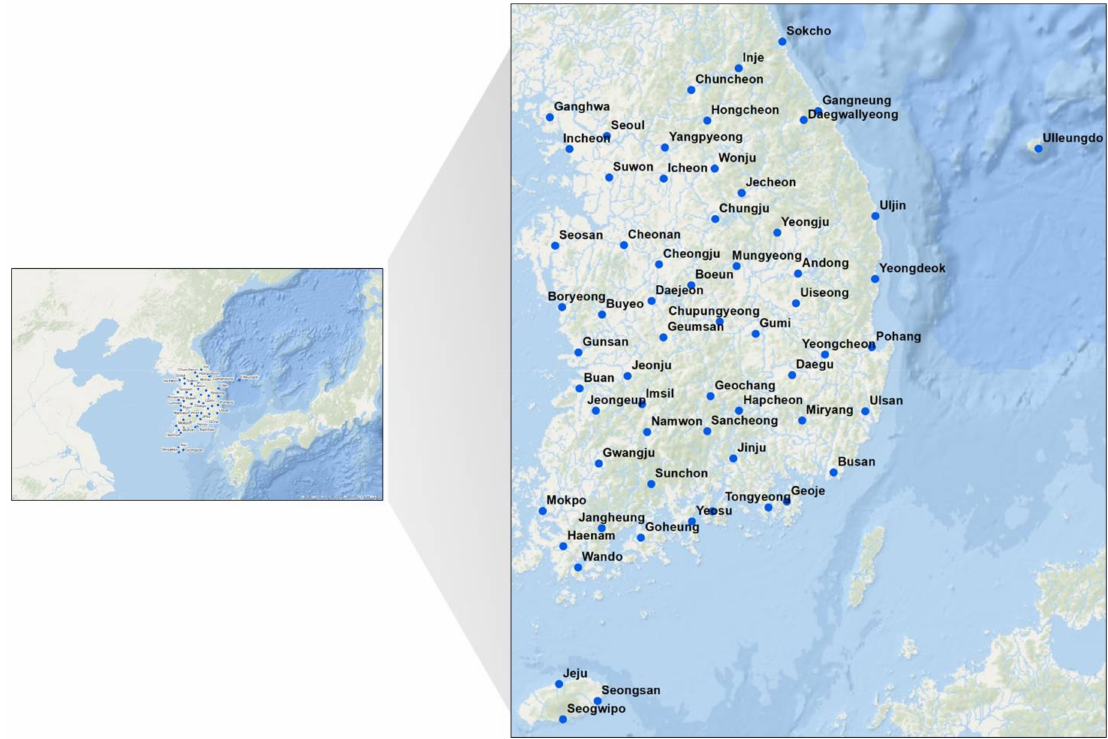
each grid. Observations of meteorological stations are extended to spatial grid data using the inverse distance method.